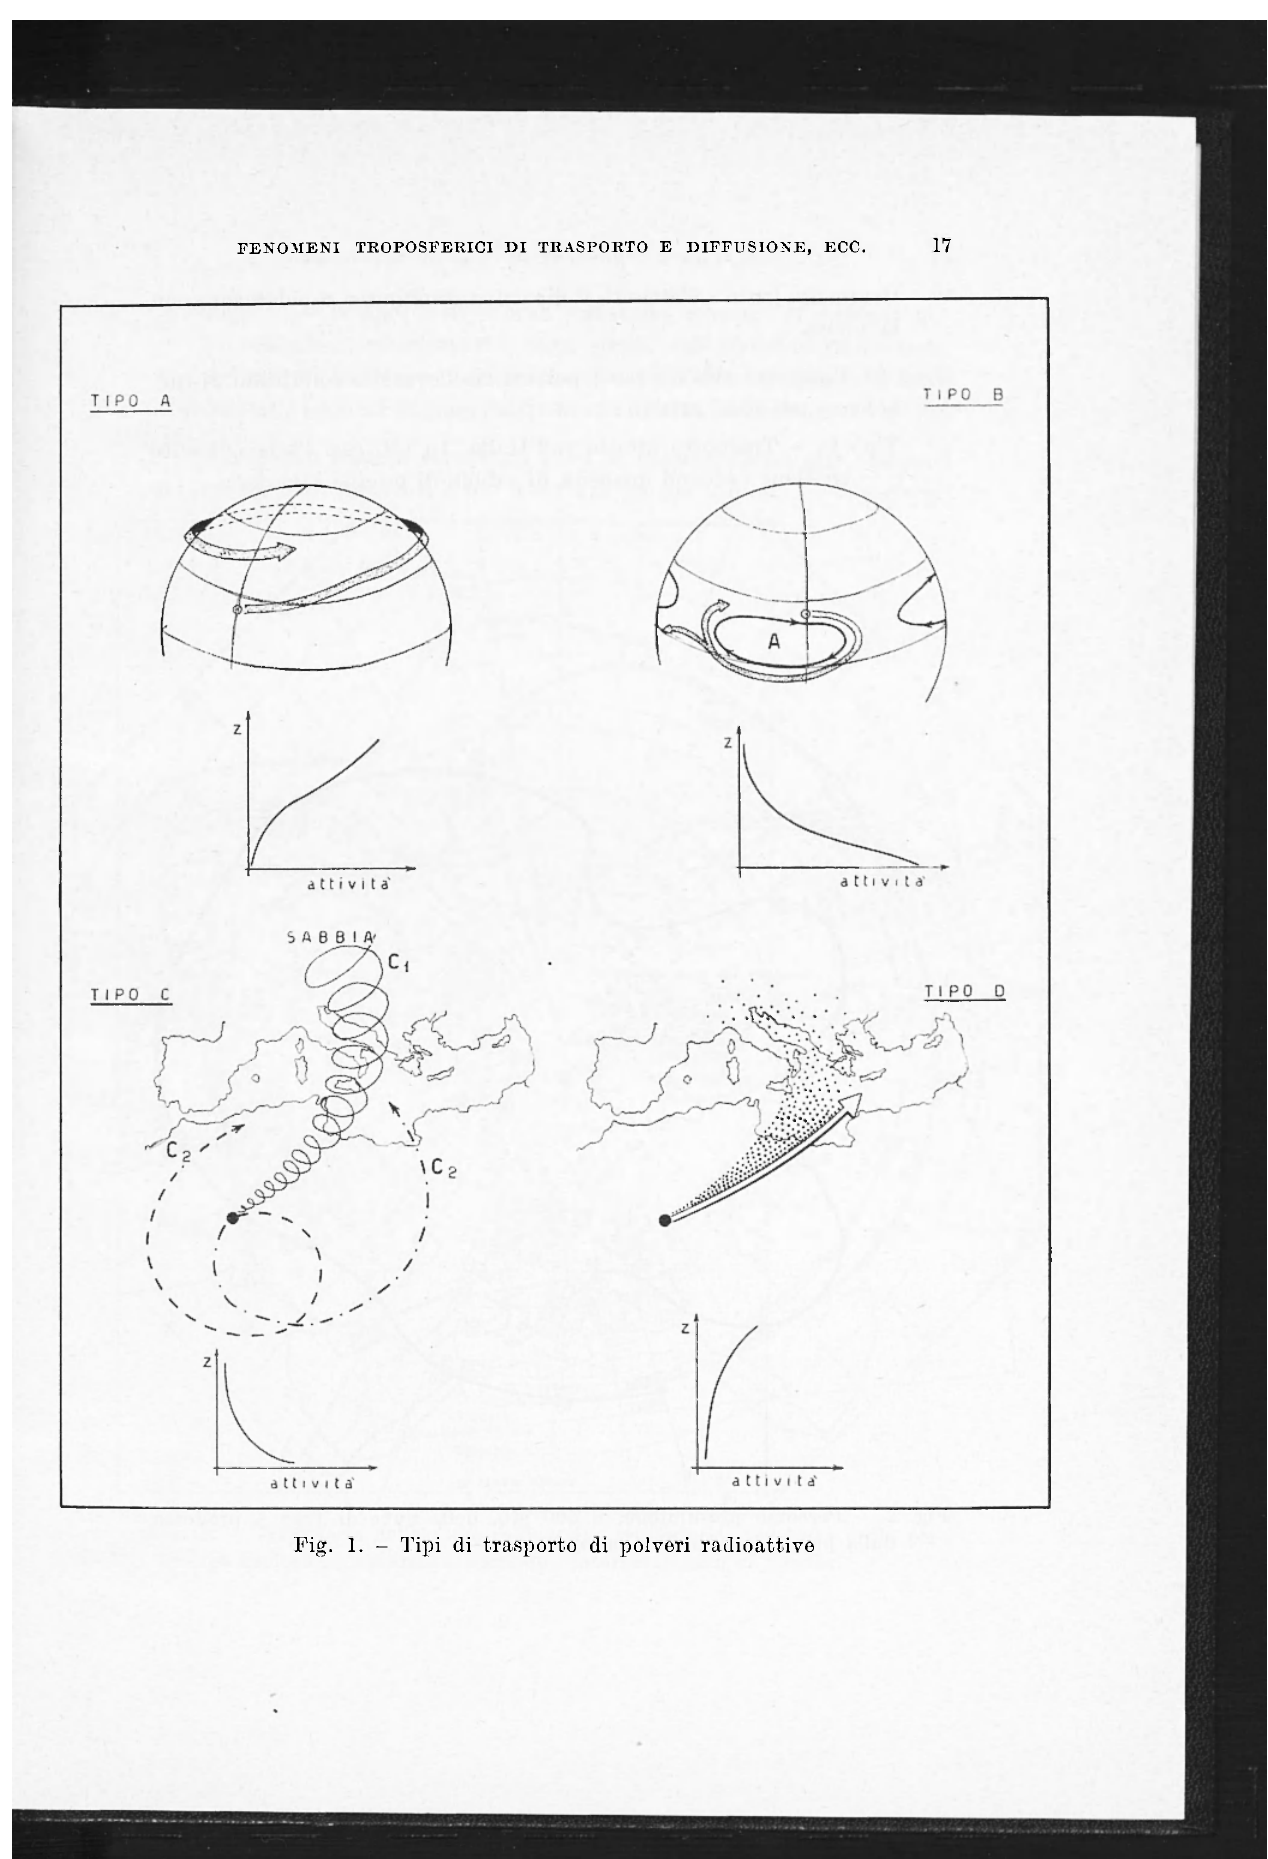
Fig. 1. - Tipi di trasporto di polveri